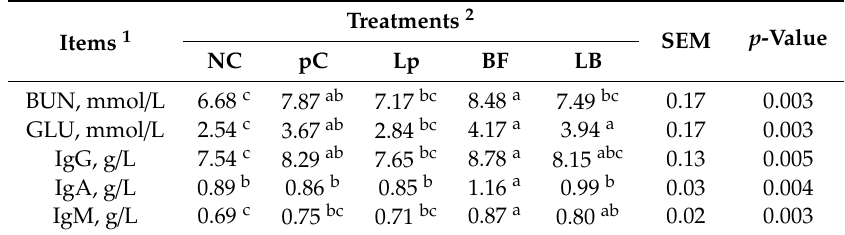
Table 4. Effects of L. plantarum , tartary buckwheat flavones, and their compound on serum Table 4. E ff ects of L. plantarum , tartary buckwheat flavones, and their compound on serum biochemical biochemical and immune indices of weaned piglets. and immune indices of weaned piglets.